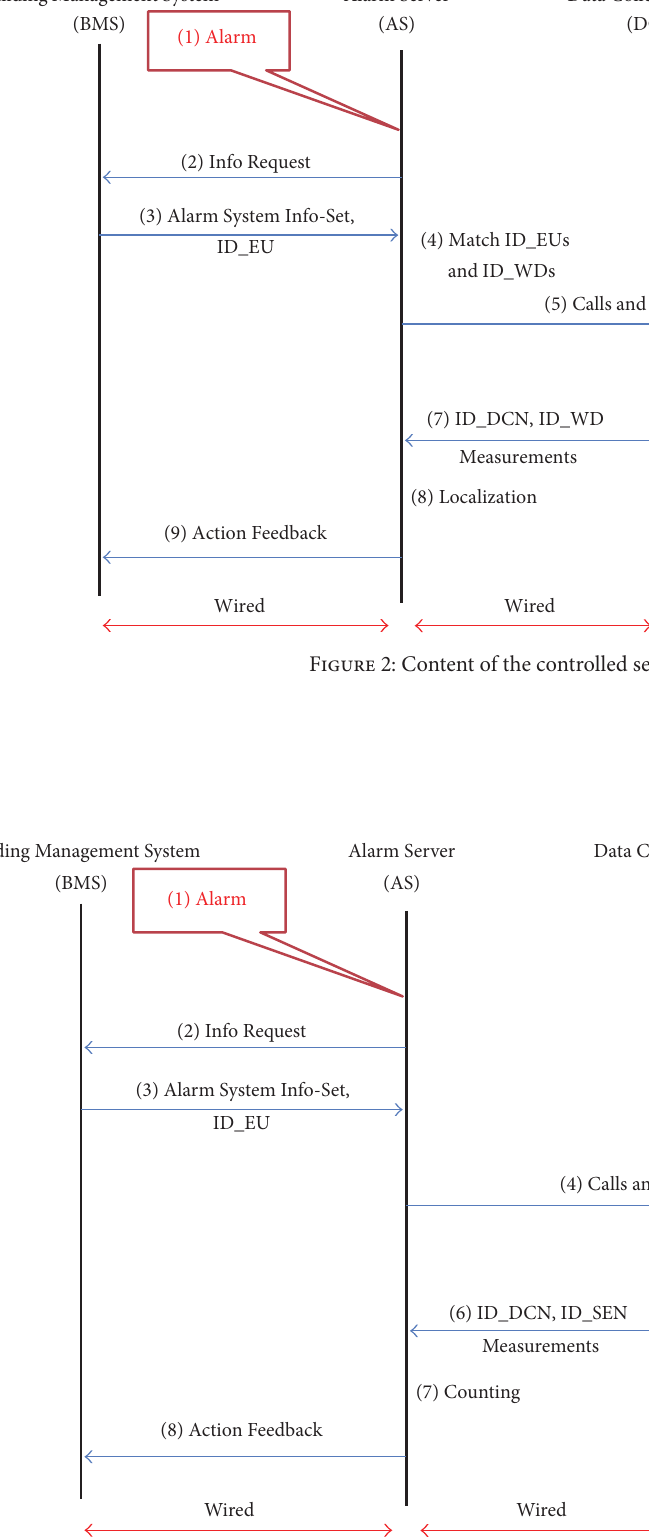
Figure 3: Content of the dynamic